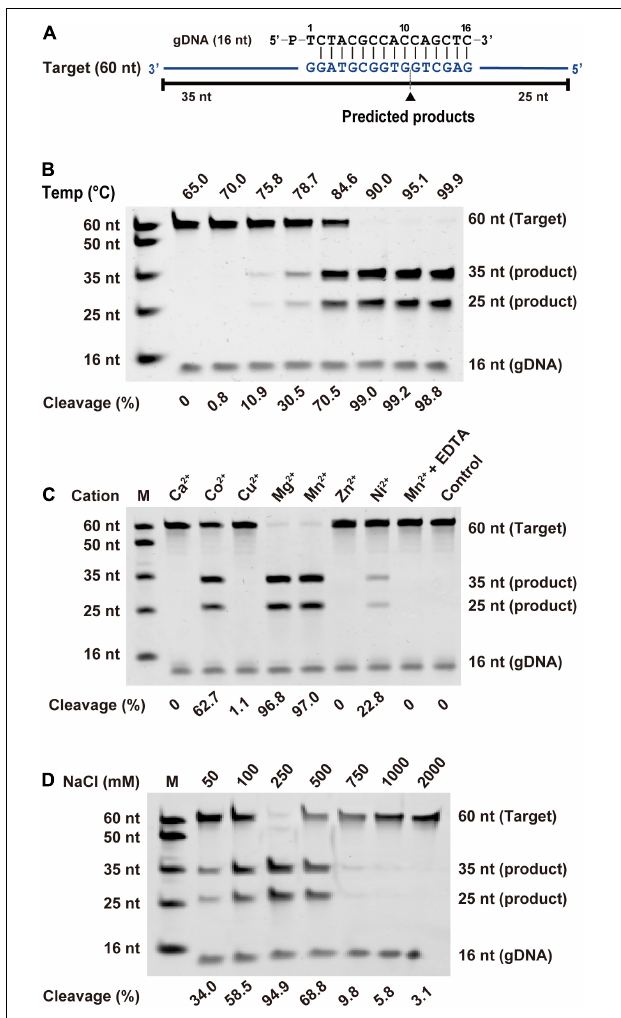
FIGURE 2 | Effects of temperature, metal ion, and NaCl on Fp Ago cleavage activity. (A) Synthetic ssDNA guide (black) and target (blue). Predicted cleavage positions are indicated with a black triangle, black lines indicate the predicted 25 and 35 nt cleavage products from 60 nt target. (B) The optimal temperature of Fp Ago. (C) The divalent metal ions preferences of Fp Ago. Substrate cleavage was performed in the presence of different divalent metal ions and EDTA with a final concentration of 0.5 mM. (D) Effect of NaCl concentrations on the enzyme activity of Fp Ago. Cleavage experiments were carried out at the 1:5:2 molar ratio (400 nM Fp Ago: 2000 nM guide: 800 nM target) in reaction buffer containing 0.5 mM Mn 2 + for 15 min at 95 ◦